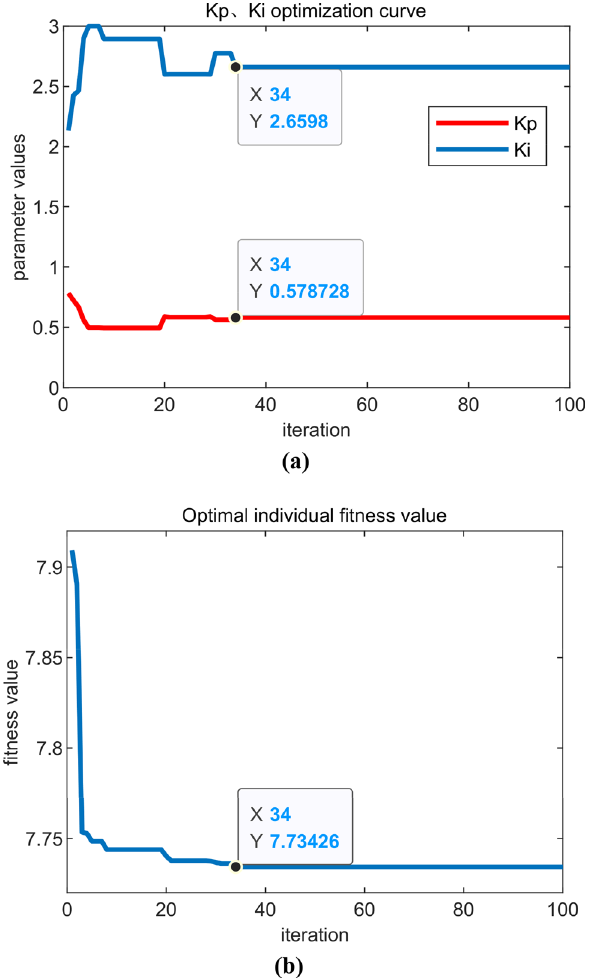
Fig. 12 PF-PI controller optimal a scale factor and b fitness value